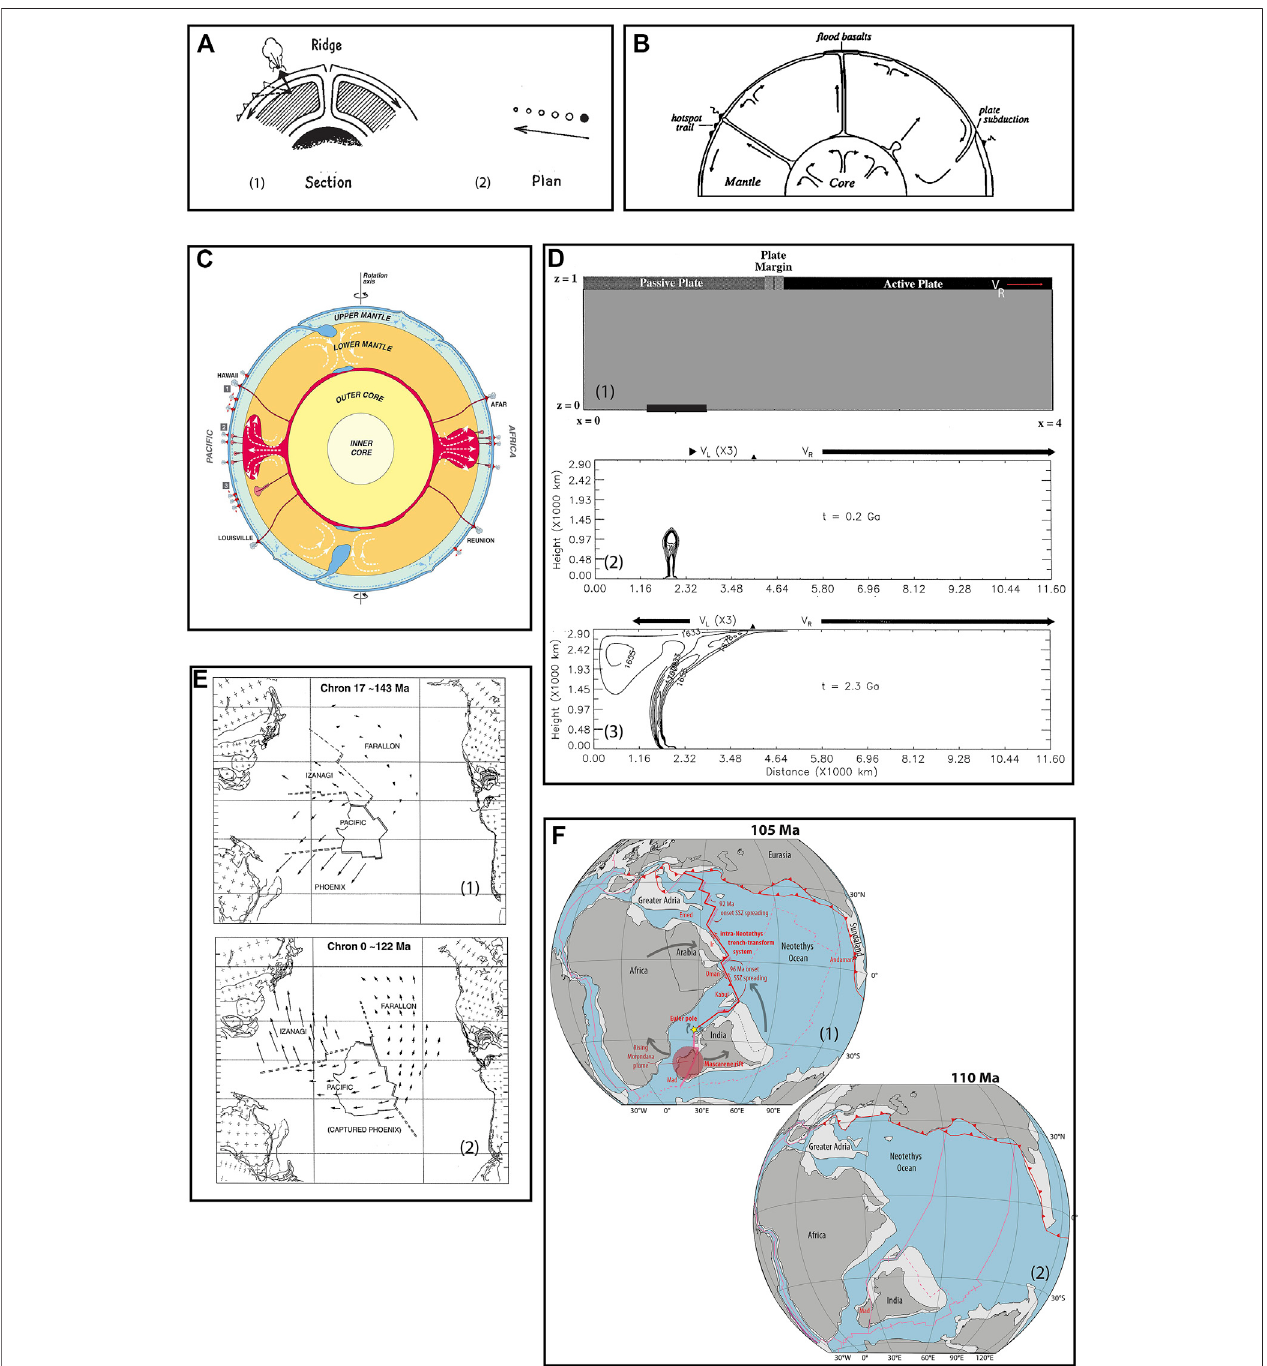
FIGURE1|(A) Wilson ’ shypothesisforthedevelopmentoftheHawaiian-Emperorchain.Movinglithosphereoveraquasi-stationarymagmasourceresultsinformationofachain of volcanoes ( fi gure is adapted from Wilson, 1963). (B) Schematic illustration of mantle convection by Duncan and Richards (1991). Plates form and separate at spreading ridges and disappear in subduction zones. Gravitationally unstable hot mantle plumes may originate from near the core-mantle boundary. Partial melting ofa rising plume head atthebase of the lithospheregenerates fl oodbasaltsandlong-livedplumetailsformhotspottrails(chainofseamountsandislands)asplatesmoveacrossthem(FigureisadaptedfromDuncanand Richards,1991). (C) TypesofhotspotsbasedonCourtillotetal.(2003): (1) primaryplumesaredeep-rooted,comingfromthecore-mantleboundary, (2) secondaryplumesoriginateat thetransitionzoneabovetwosuperplumesbeneathAfricaandPaci fi c,and (3) tertiaryorAndersonianplumeswhicharethepassiveresponseofplate-relatedstresses( fi gureisadapted fromCourtillotetal.,2003). (D) Numericalmodelsetup(panel1)andresults(panels2,3)ofRatcliffetal.(1998)toinvestigatetheeffectofrisingplumeheadonplatedecoupling. (1) :Inthe initialmodelsetup,anactiveplatemovestowardstheright,pushingthepassiveplatewithit. (2,3) :Resultsshowthatarisingmantleplumeheadcandecouplepassivefromactiveplates andchangethedirectionofitsmotion.FigureisobtainedfromRatcliffetal.(1998). (E) ReconstructionofthePaci fi cPlateanditsneighboringplates,basedonRatcliffetal.(1998),showing plate reorganization due to arrival of the Ontong-Java plume at ∼ 122 Ma. (F) Plate reconstruction model of Van Hinsbergen et al. (2021) showing formation of a long plate boundary following arrival of a mantle plume beneath Madagascar-India. Figure is obtained from van Hinsbergen et al. (2021).